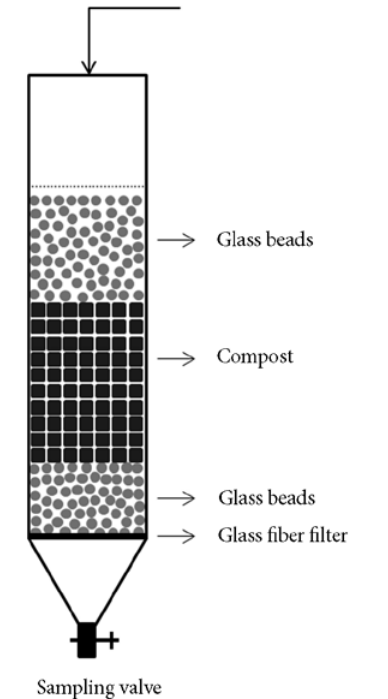
Fig. 1. Schematic view of the column used in the the column. Solutions were fed into the column (equipped with a tap at the bottom) from the upper part via a peris- taltic pump (Watson Marlow 505 DI).